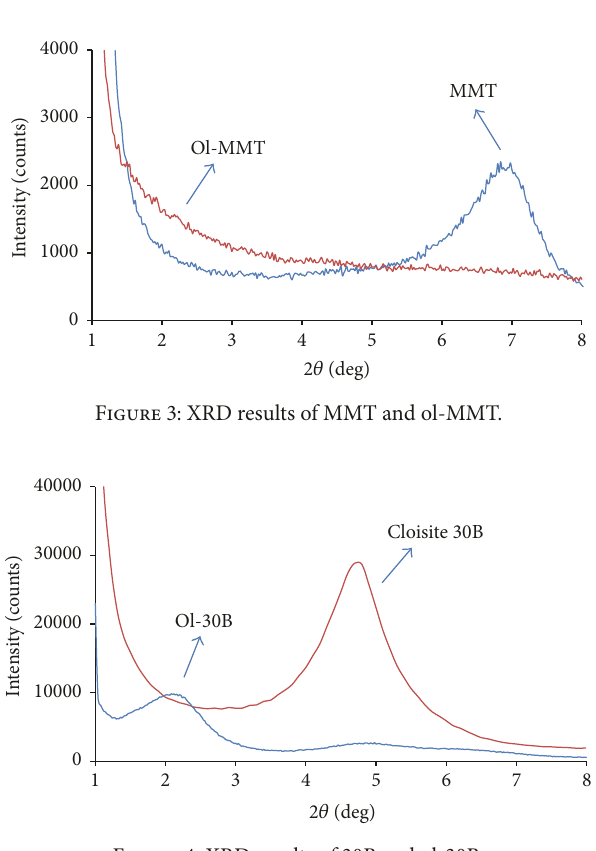
Figure 4: XRD results of 30B and ol-30B.